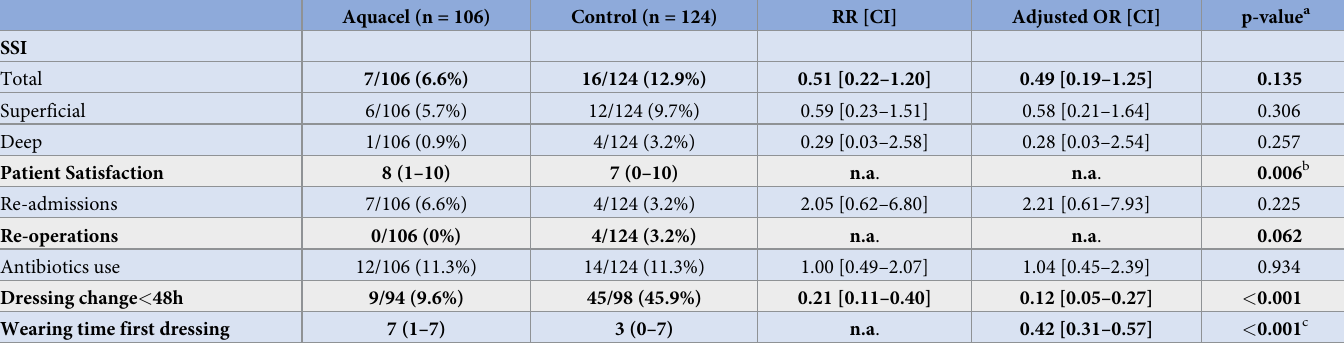
Table 2. Outcome measures and comparison between the groups.